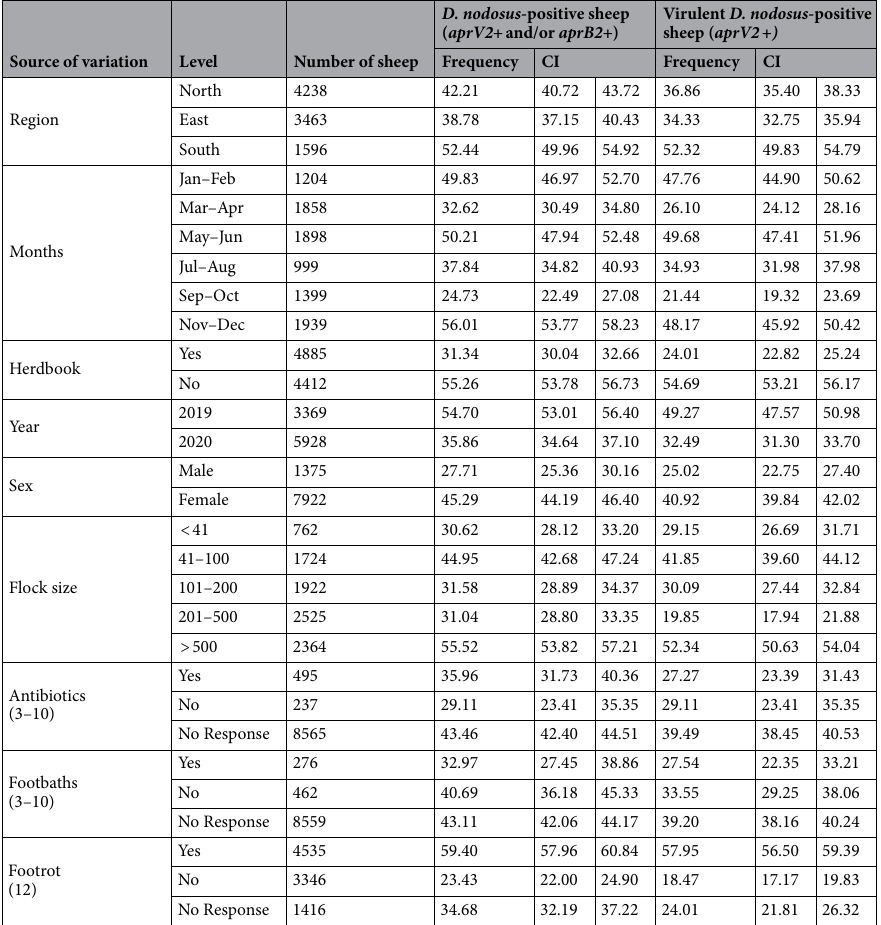
Table 1. Number, frequencies (%) and 95% confidence intervals (CI) of sheep tested positive for D. nodosus ( aprV2 + and/or aprB2 +) and positive for virulent D. nodosus ( aprV2 +) by real-time PCR in the different levels of each source of